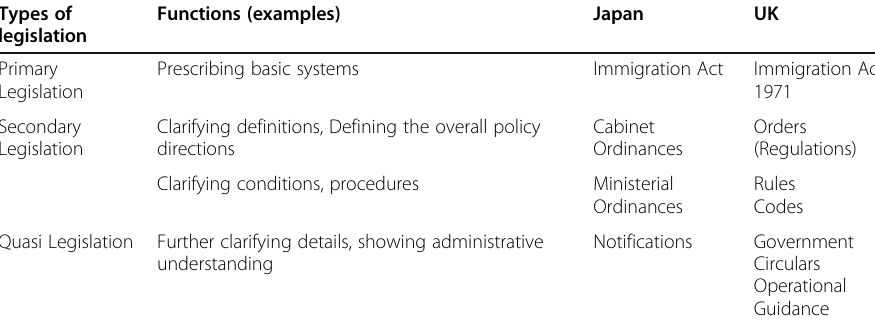
Table 1 legislative structure of immigration control in Japan and the